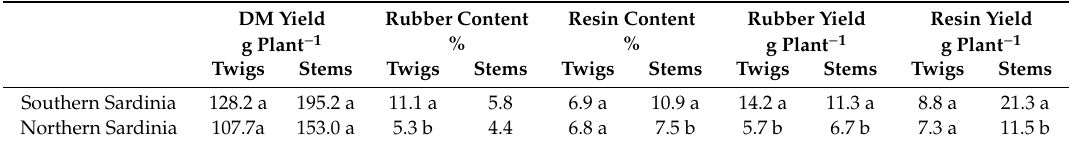
Table 8. Means of aboveground biomass fractions, rubber and resin contents and yields of P803 and 11591 lines at the two sites. DM Yield Rubber Content Resin Content Rubber Yield Resin Yield g Plant − 1 % % g Plant − 1 g Plant − 1 Twigs Stems Twigs Stems Twigs Stems Twigs Stems Twigs